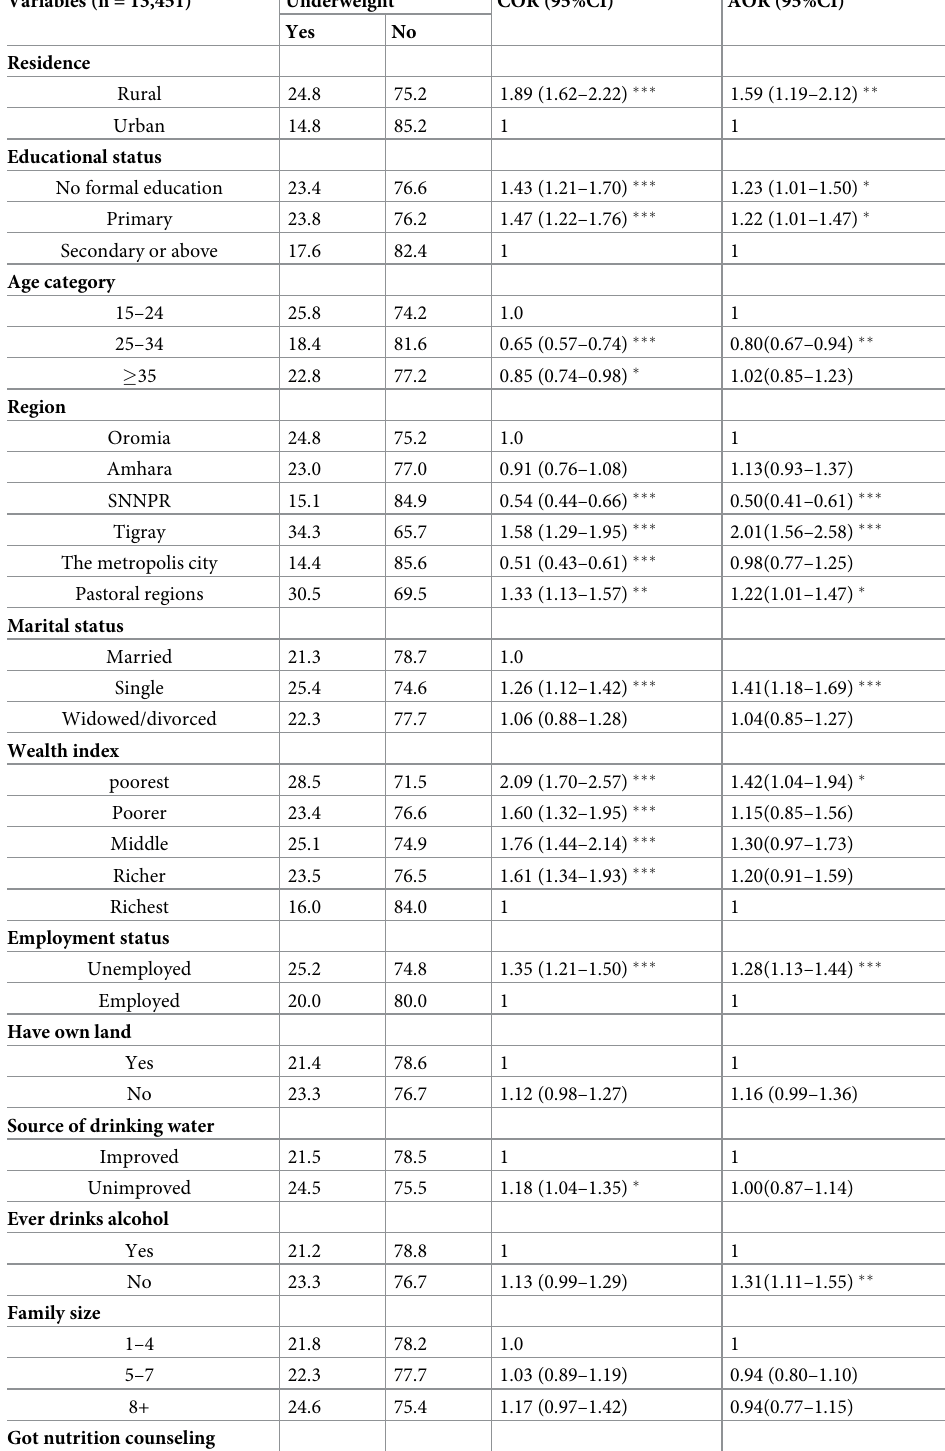
Table 2. Factors associated with chronic energy malnutrition among reproductive-age women in Ethiopia; 2016